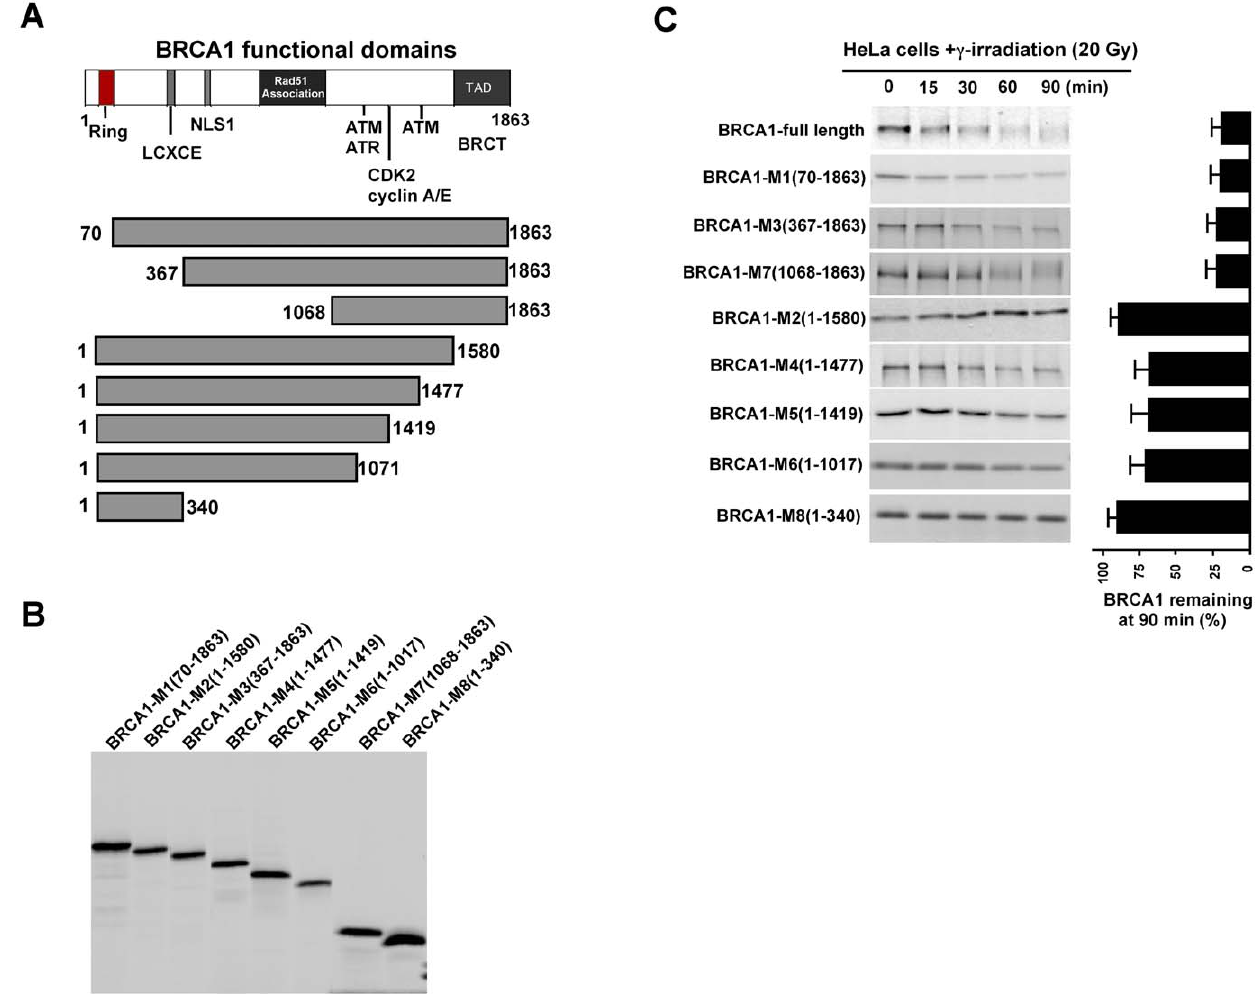
Figure 4. Mapping of functional domains mediating c irradiation-induced BRCA1 degradation. A . Schematic presentation of BRCA1 functional domains, including Ring, LCXCE, NLS Rad51 binding, ATM/ATR, CDK2/cyclin A,E, TAD domains. B . Evaluation of the expression of BRCA1 mutants. C . Protein stability for BRCA1 mutants in response to c irradiation was estimated using a cell-free protein degradation assay. HeLa cell lysate was prepared from the cells exposed to c irradiation. 35 S labeled and in vitro translated BRCA1 mutant proteins were subject to the functional lysate with supplements for protein degradation. Aliquot was collected at indicated time points and protein sample was resolved by SDS-PAGE. Protein stability for BRCA1 mutants in the presence of c irradiation was reflected by autoradiography. Quantification was done with a Fuji PhosphorImager.